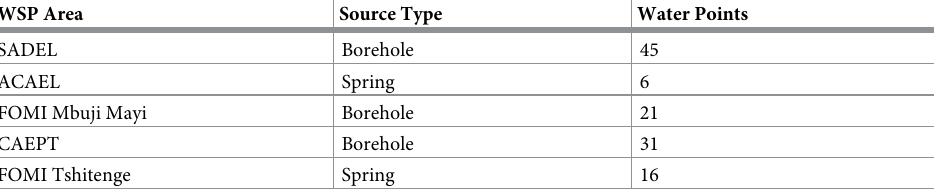
Table 5. WSPs with water quality assessments conducted, with source type and collection points